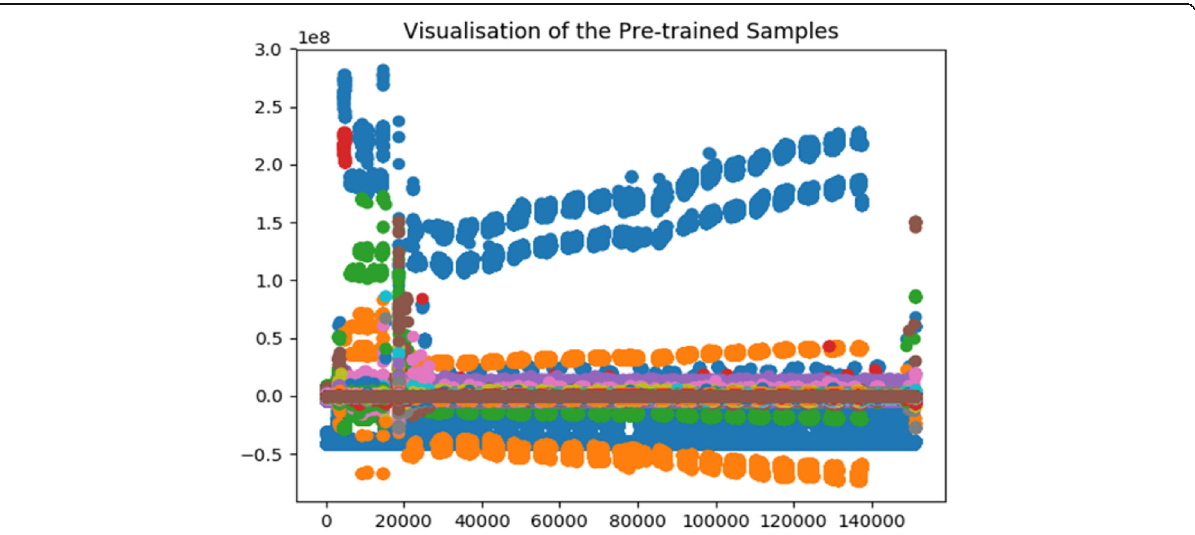
Fig. 3 Visualisation of the Pre-trained Samples